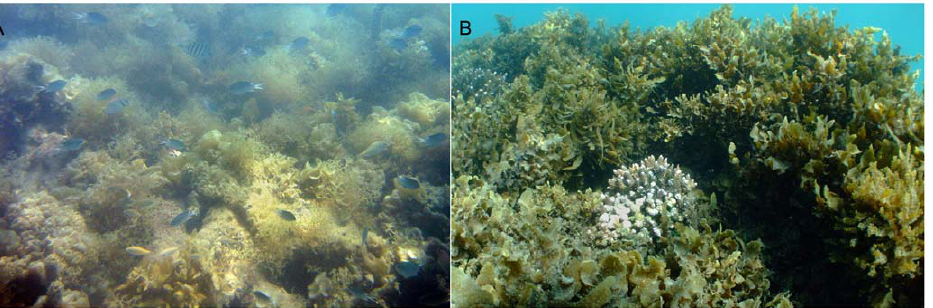
Figure 1. Macroalgae assemblages at Long Island and Dunk Island. (A) Mat-forming macroalgal assemblage dominated by Hydroclathrus clathratus , Long Island. (B) Canopy-forming macroalgal assemblage, dominated by Sargassum spp ., Dunk Island.